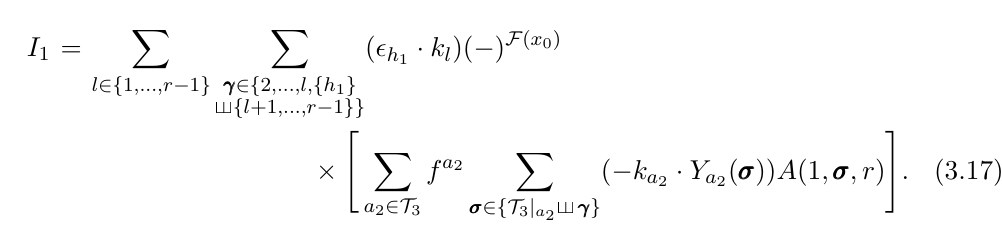
Figure 11 . A typical skeleton in example-1 is presented as the graph (a) which consists of three components. Graphs (b) and (c) are possible structures of skeletons in example-2. The subgraphs U and L in each of (b) and (c) are correspondingly the (cid:12)nal upper and lower blocks. in eq. (3.15) is expressed